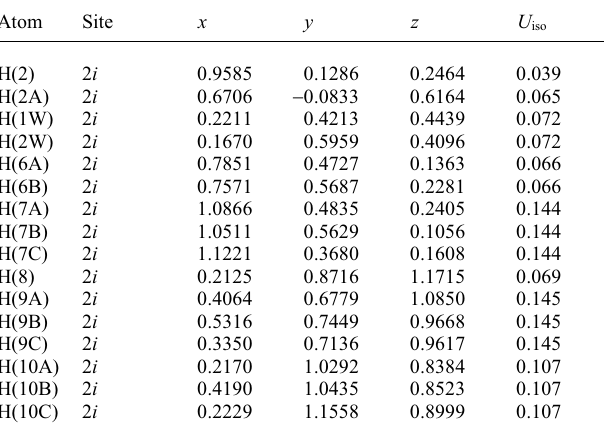
Table 2. Atomic coordinates and displacement parameters (in Å 2 )